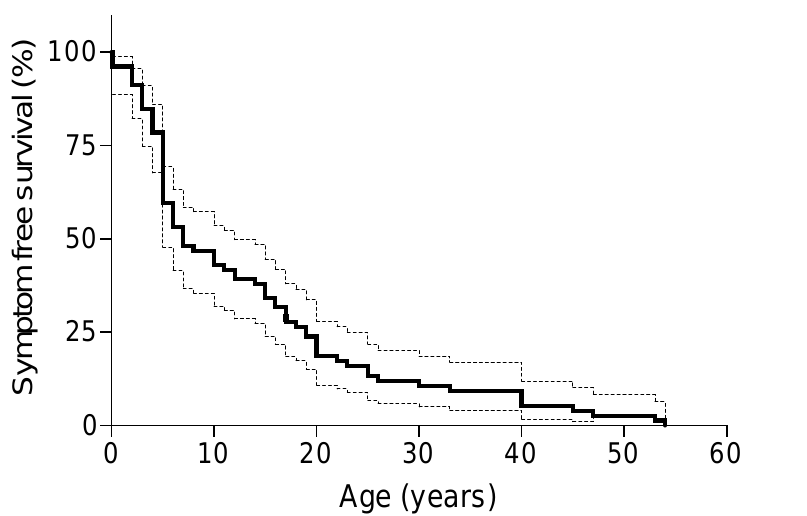
Figure 5. Kaplan–Meier survival curve for symptom-free survival (95% confidence interval) in Figure 5. Kaplan – Meier survival curve for symptom-free survival (95% confidence interval) in n = n = 78 patients. Predicted incidence of first symptoms at a median age of 78 patients. Predicted incidence of first symptoms at a median age of 7.